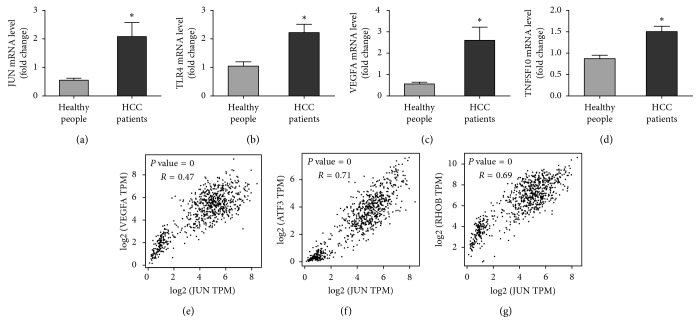
The mRNA level of hub genes and correlation analysis of any two hub genes in GEPIA. (a–d) The mRNA level of 4 hub genes (JUN, TLR4, VEGFA, and TNFSF10) in PBMC (∗Differences between the groups were significant (P < 0.05)). (e) JUN and VEGFA correlation analysis (P value = 0, R=0.47). (f) JUN and ATF3 correlation analysis (P value = 0, R=0.71). (g) JUN and RHOB correlation analysis (P value = 0, R=0.69).